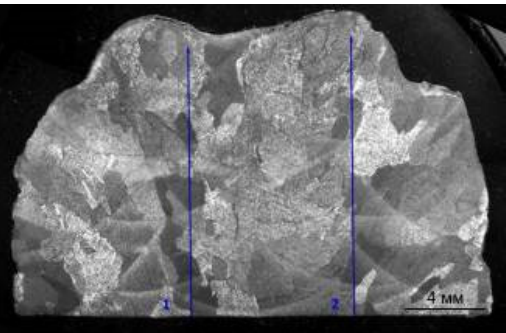
Figure 4. An example of the microhardness measurements of the deposited samples. The measurements were carried out in the form of two parallel tracks of 100 measurements with a step of 0.15 mm.